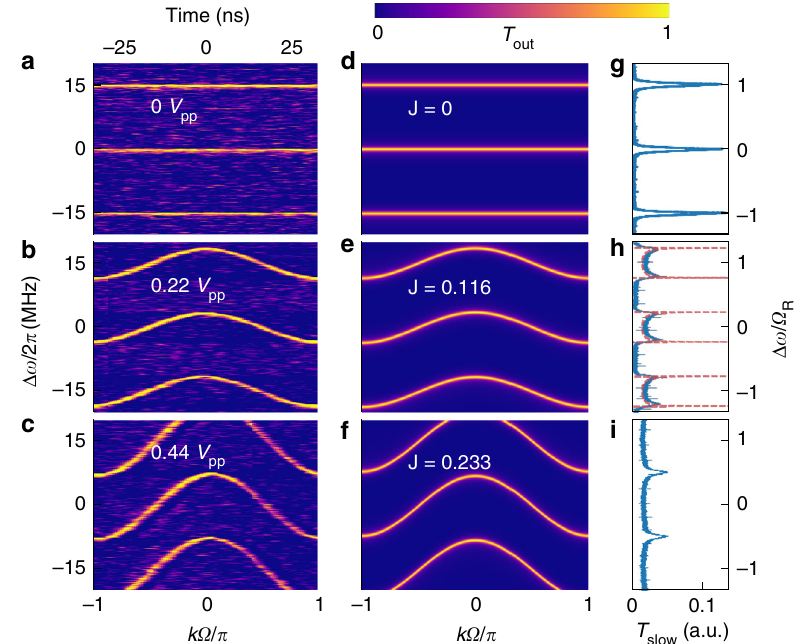
Fig. 3 Band structure for on-resonance modulation Ω M = Ω R = 2 π ⋅ 15.04 MHz. a – c Experimentally measured time-resolved transmission. d – f Theoretical transmission based on Eq. (15). The bottom x-axis represents time (the quasimomentum) in units of π / Ω R , while the top x-axis of ( a – c ) presents the time in real units. The y-axis represents the input laser ’ s detuning from the ring ’ s resonance frequency, allowing us access to different quasienergies ε k (left: real units, right: normalized to FSR). On increasing the coupling J (theory) or the amplitude of modulation V pp (experiment), cosinusoidal bands with increasing extent in quasienergy are observed, in agreement with ε k = 2 J cos k Ω . See also Supplementary Movie 1. g – i Corresponding time-averaged transmission through the modulated cavity. In ( g ), typical Lorentzian resonances of the unmodulated cavity are seen. In ( h ), the photonic density of states (DOS) in synthetic space is observed. The experimental data (blue) matches the expected density of states (red dashed) of a 1D tight-binding model with nearest neighbor coupling. In the bottom panels ( c ), ( f , i ), the modulation-induced coupling is strong enough to cause overlap of Floquet bands